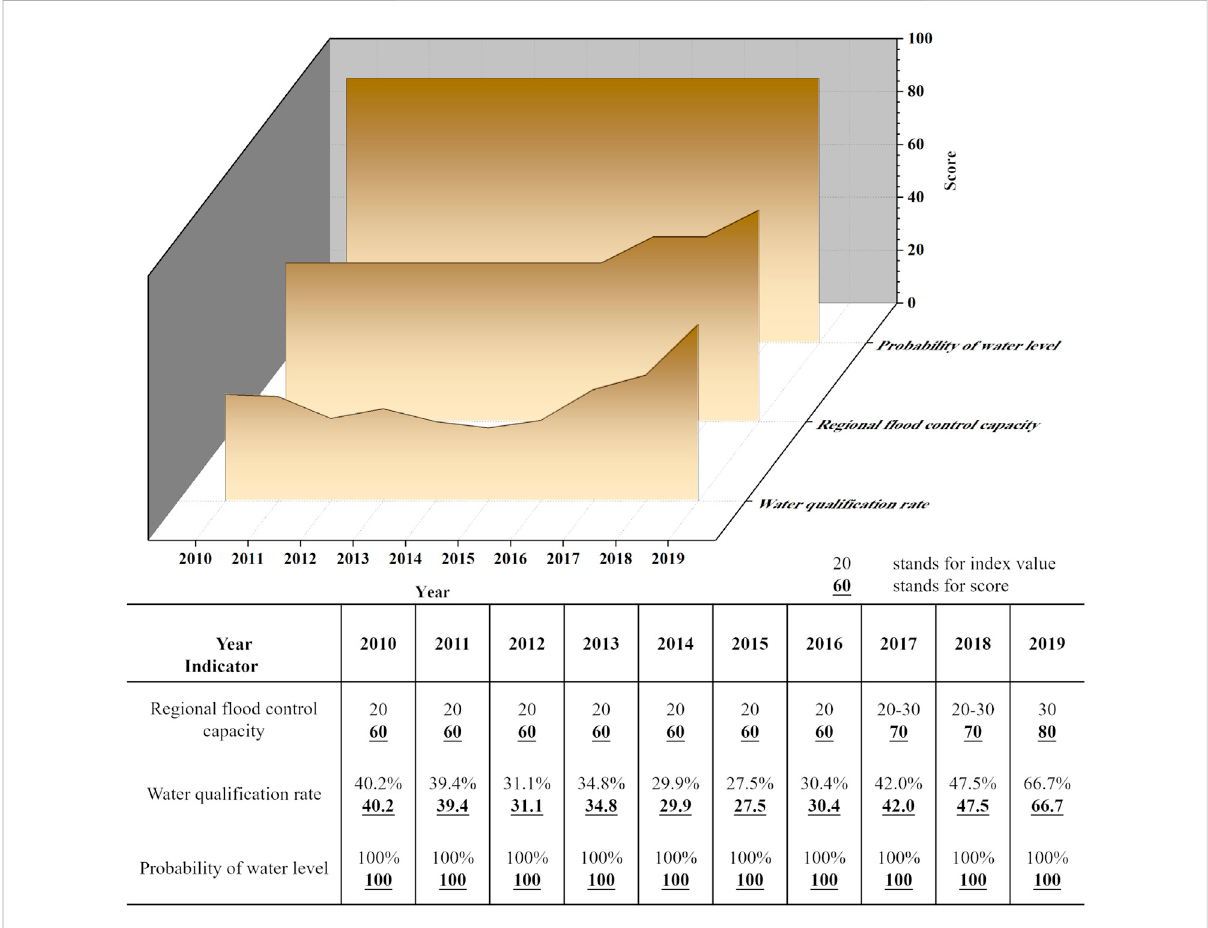
FIGURE 5 Results of the assessment of water